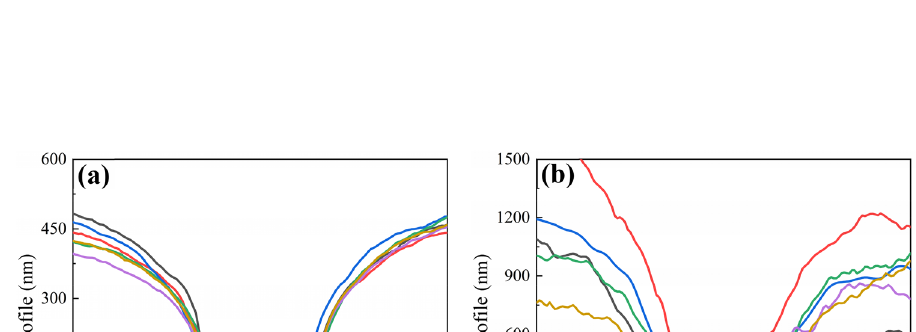
Figure 11. The 3D removal characteristics and corresponded 2D morphology features of jet spots using the BT3 (the time, pressure and nozzle are 10 s, 0.5 MPa and 1 mm, respectively. λ = 632 nm).